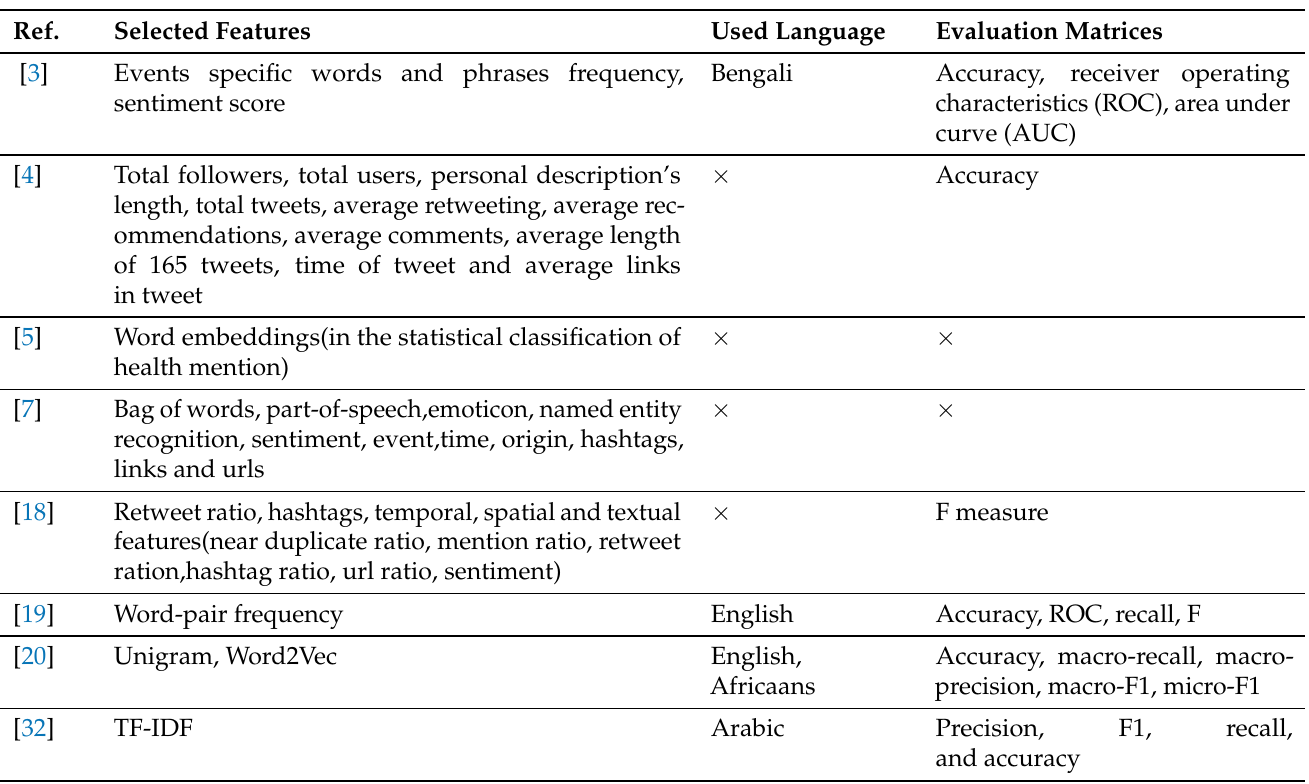
Table 1. A brief description of the selected features, studied languages, and evaluation matrices used in articles that applied shallow ML